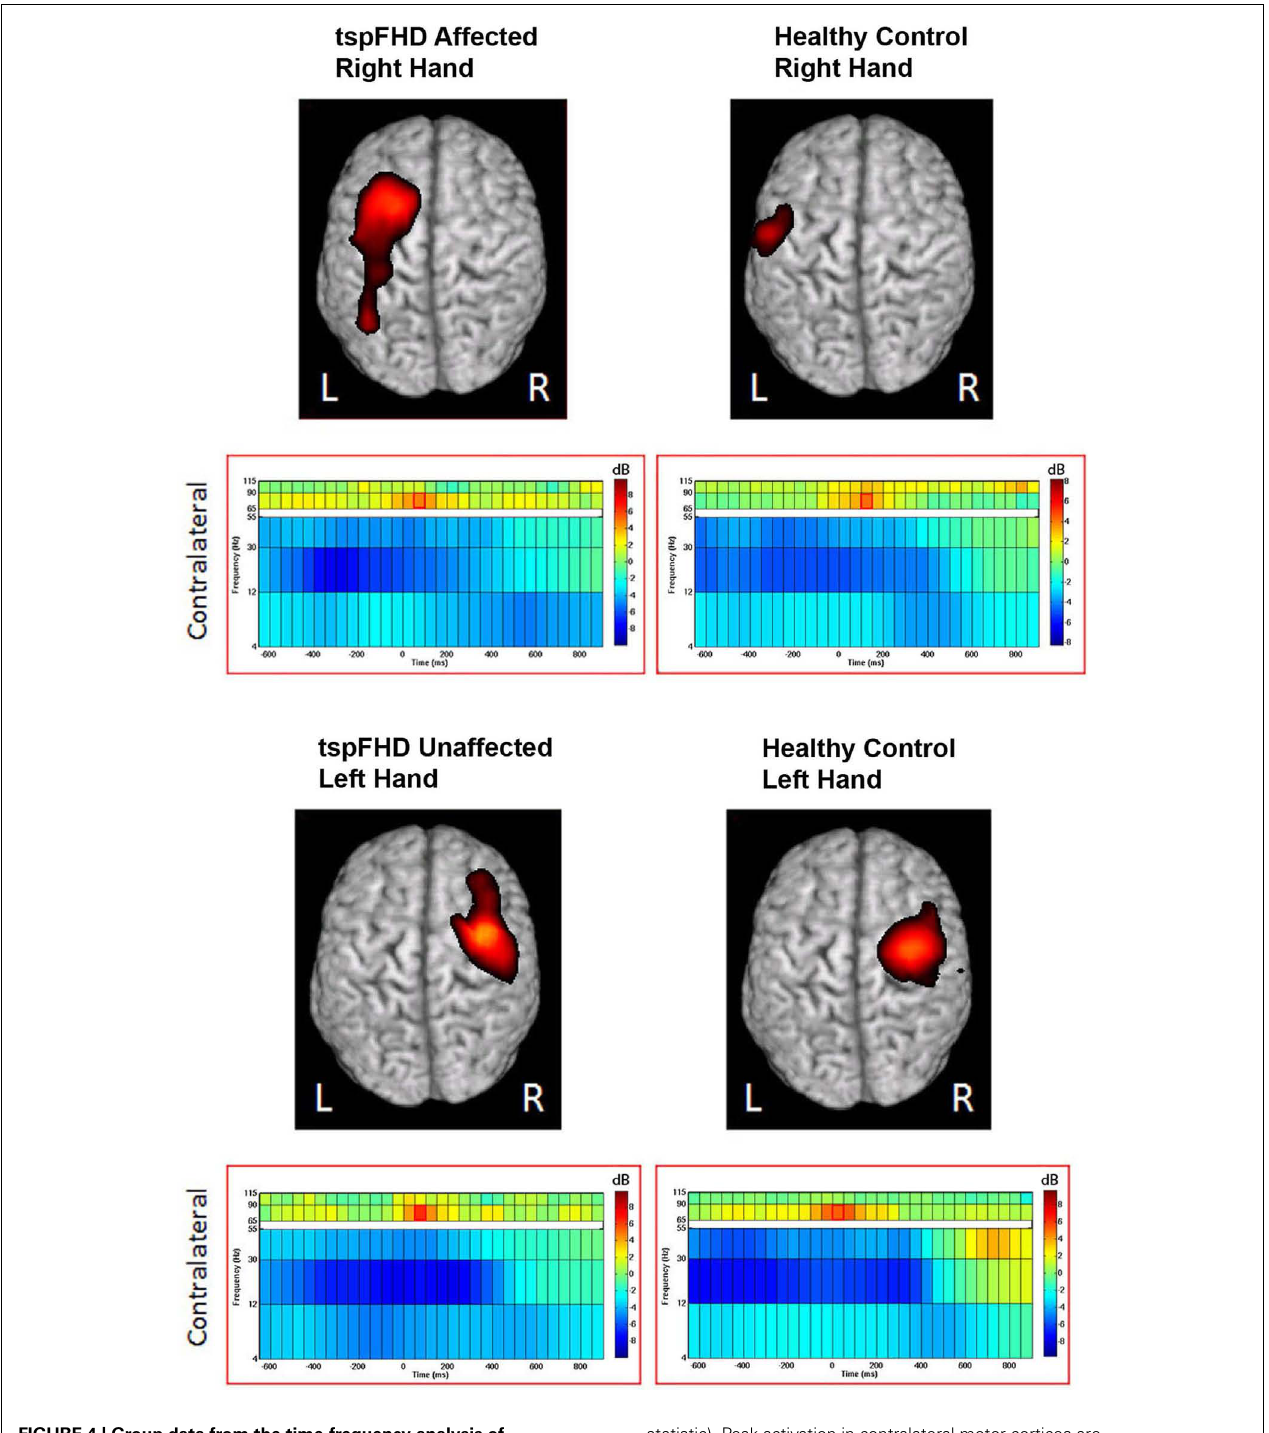
FIGURE 4 | Group data from the time-frequency analysis of high gamma band (65–90Hz) activity. Functional maps (one-sample t -test) are thresholded at p < 0.05 (maximal